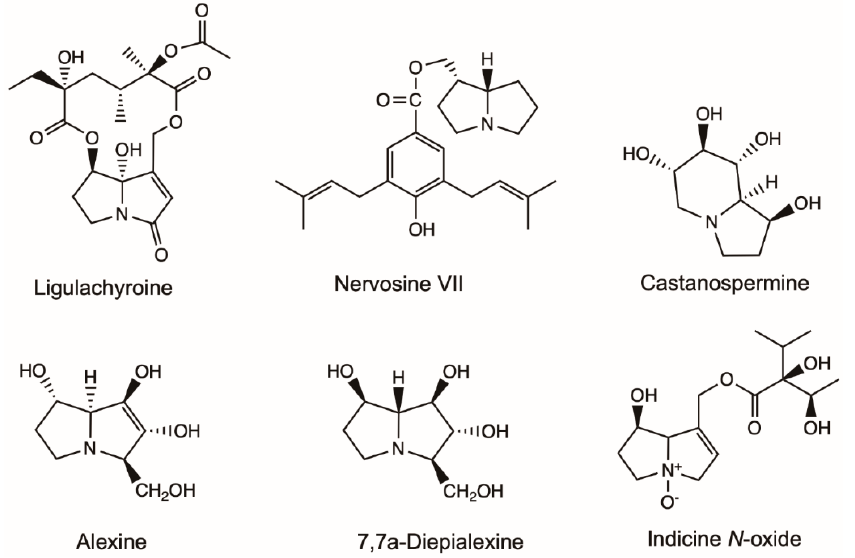
Figure 5. Effective chemical structures of pyrrolizidine alkaloids with anti-cancer or anti-virus activities in this review. Structures of lycopsamine, retronecine, heliotrine and 7-Angeloylheliotrine with anti-cancer activities were listed in Figure